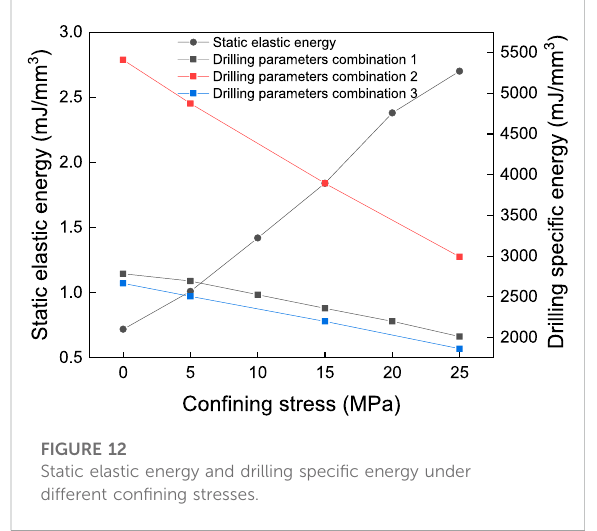
FIGURE 12 Static elastic energy and drilling speci fi c energy under different con fi ning stresses.